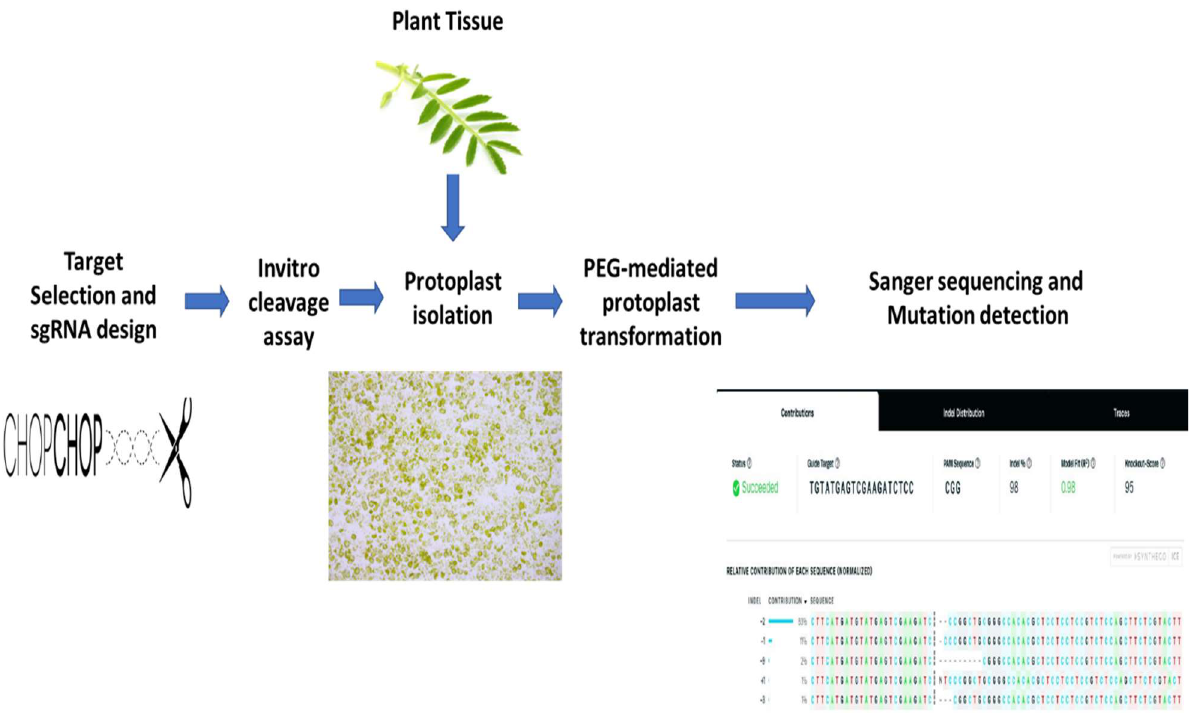
Figure 1. Graphical abstract: An overview of the CRISPR/Cas9 DNA free gene editing in the chickpea protoplast. The protoplasts of young leaves were isolated and transformed with CRISPR RNP complex under optimum conditions. The DNA was extracted from the protoplast control and test samples and sent for Sanger sequencing to detect the mutations. The transformation efficiency and knockout score were identified using ICE bioinformatics tool (Synthego).